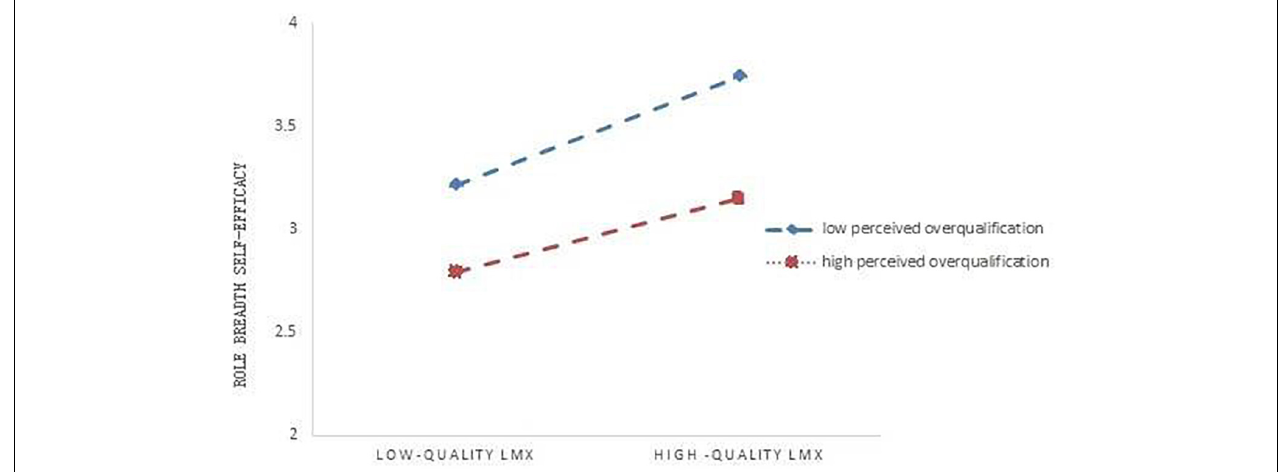
TABLE 6 | Results of the moderated mediation effect between leader-member exchange (LMX) and voice behavior. Moderator